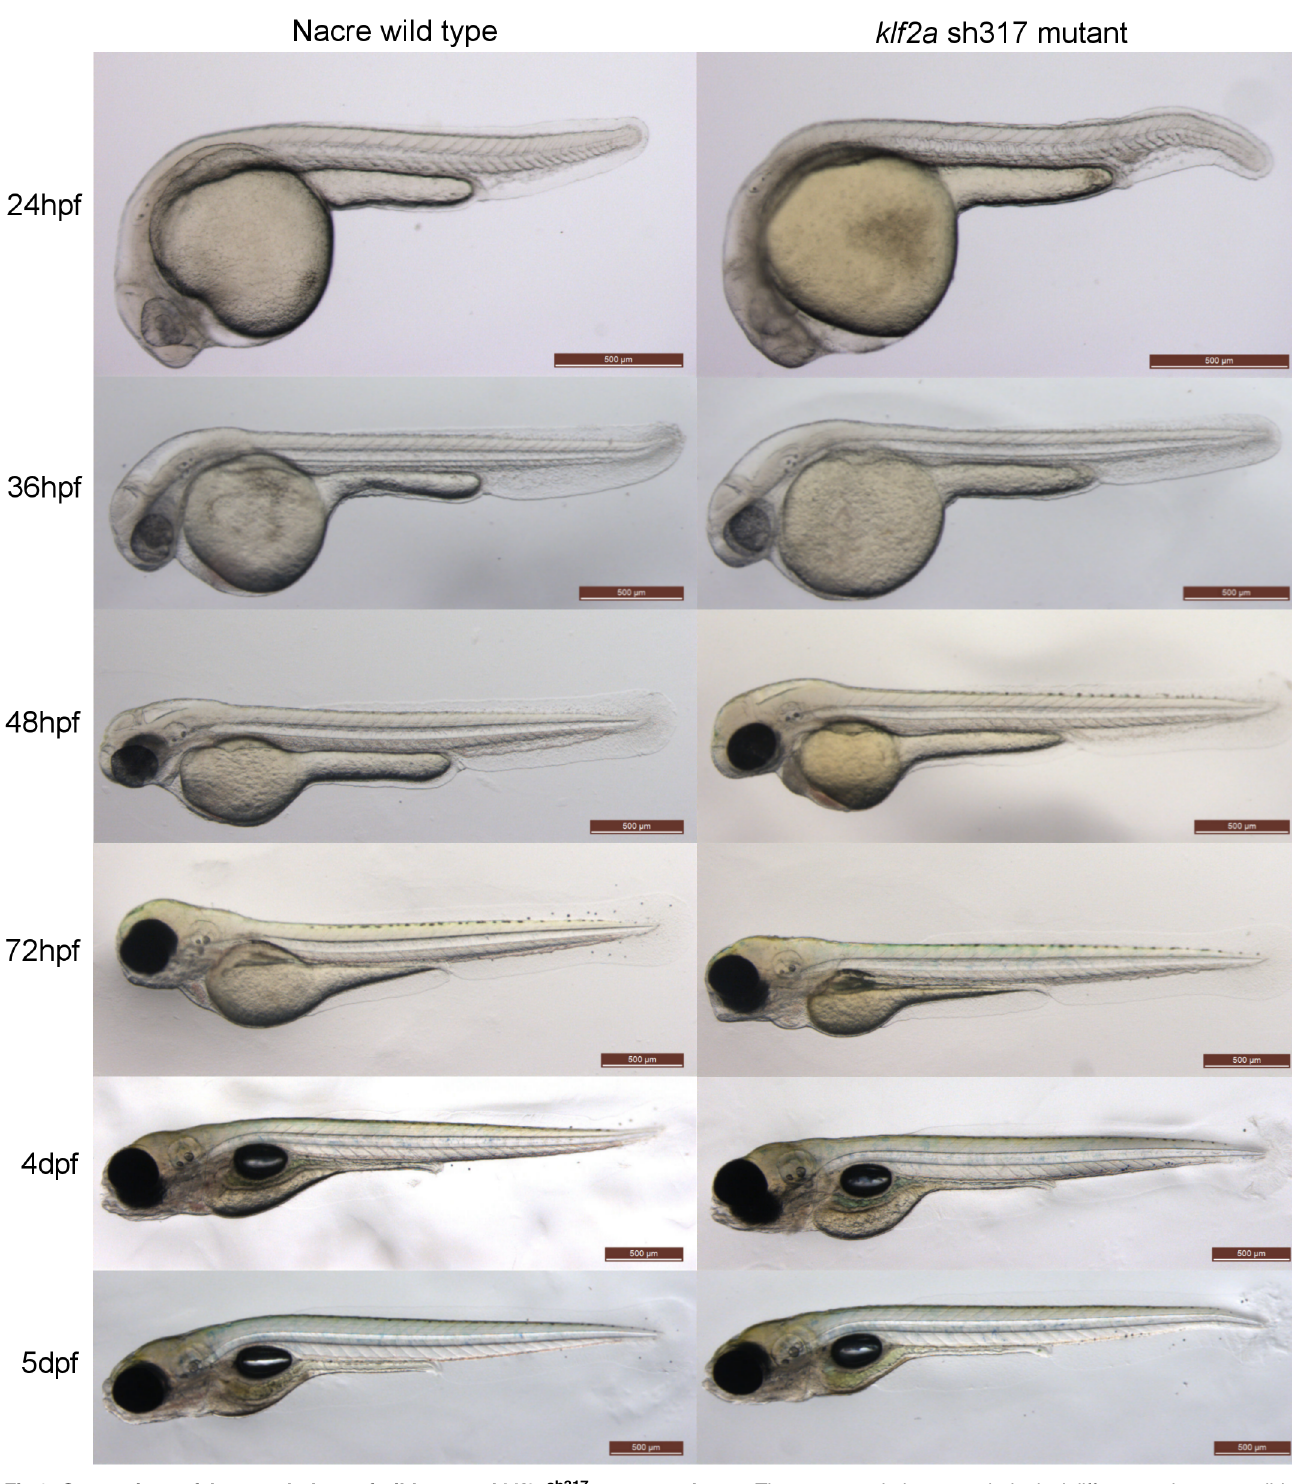
Fig 3. Comparison of the morphology of wildtype and klf2a sh317 mutant embryos. There are no obvious morphological differences between wildtype and klf2a sh317 mutant embryos up to 5dpf and also beyond up to adulthood (not shown). Scale bar = 500 μ m.